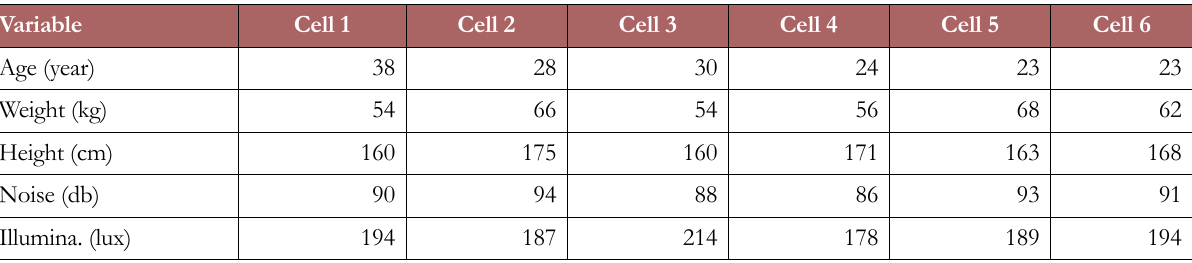
Table 3. Values of independent variables from the rear of motorcycles